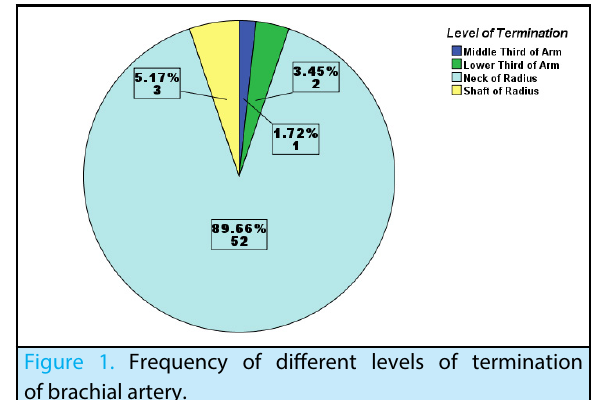
Figure 1. Frequency of different levels of termination of brachial artery.